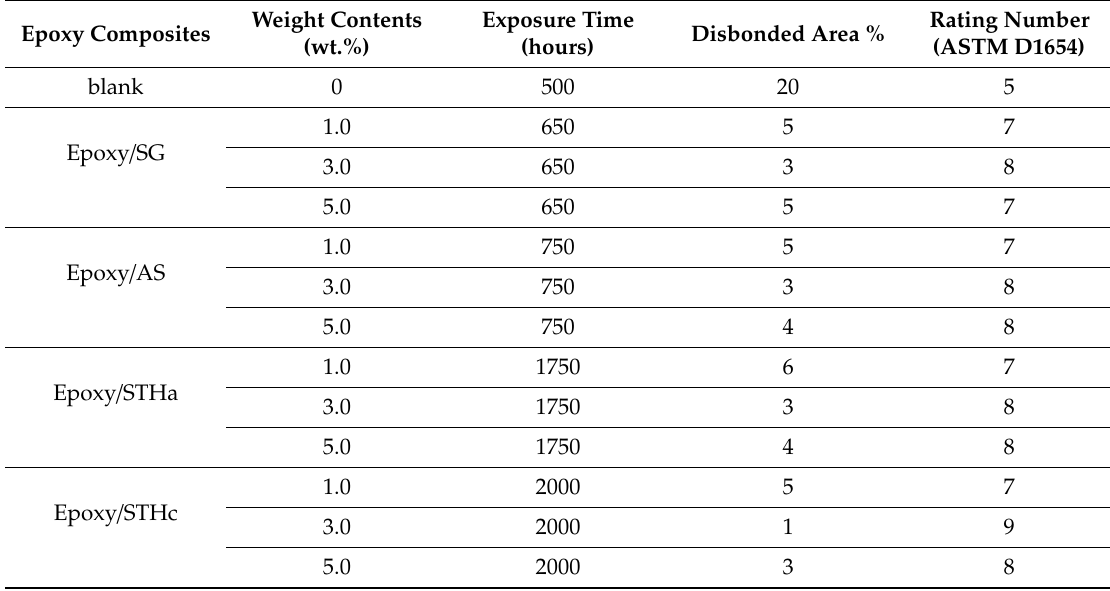
Table 2. Salt-spray resistance of the epoxy resins modified with di ff erent weight percentages of epoxy composites in the absence and presence of di ff erent weight percentages of SG, AS, STHa and STHc. Epoxy